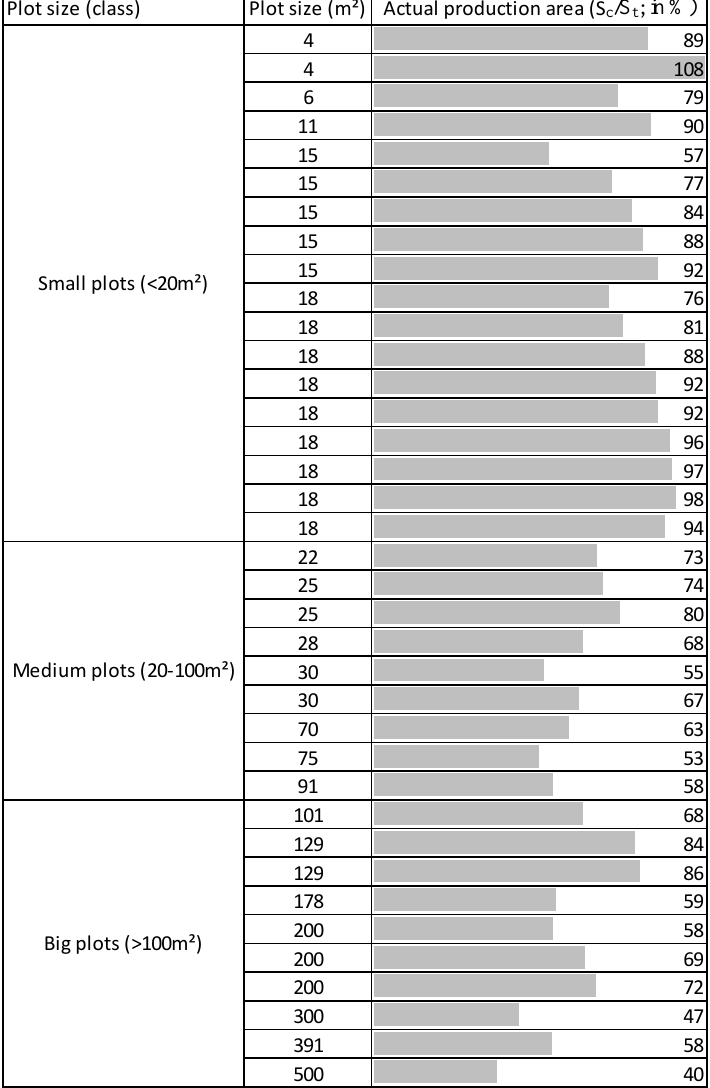
Figure 8. Share of Plot Dedicated to Food